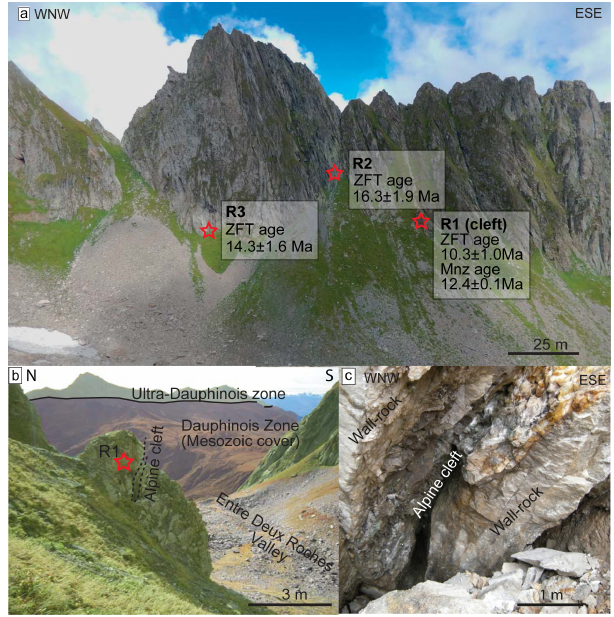
Figure 2. Photographs of the investigated outcrop. (a) Entre Deux Roches profile with location and ages of the investigated samples represented by red stars: R1 corresponds to the position of the cleft and its wall rock (45 ◦ 28 (cid:48) 52.90 (cid:48)(cid:48) N, 6 ◦ 23 (cid:48) 6.18 (cid:48)(cid:48) E), R2 and R3 were taken at 30 and 100m, respectively, away from the cleft. (b) Alpine- type cleft location with location of the R1 sample taken in the wall rock of the cleft. The N110 oriented sub-vertical vein is perpendicu- lar to the main N010-020 mylonitic sub-vertical foliation (c) Details of the Alpine-type cleft showing the hydrothermal crystals and the leached wall